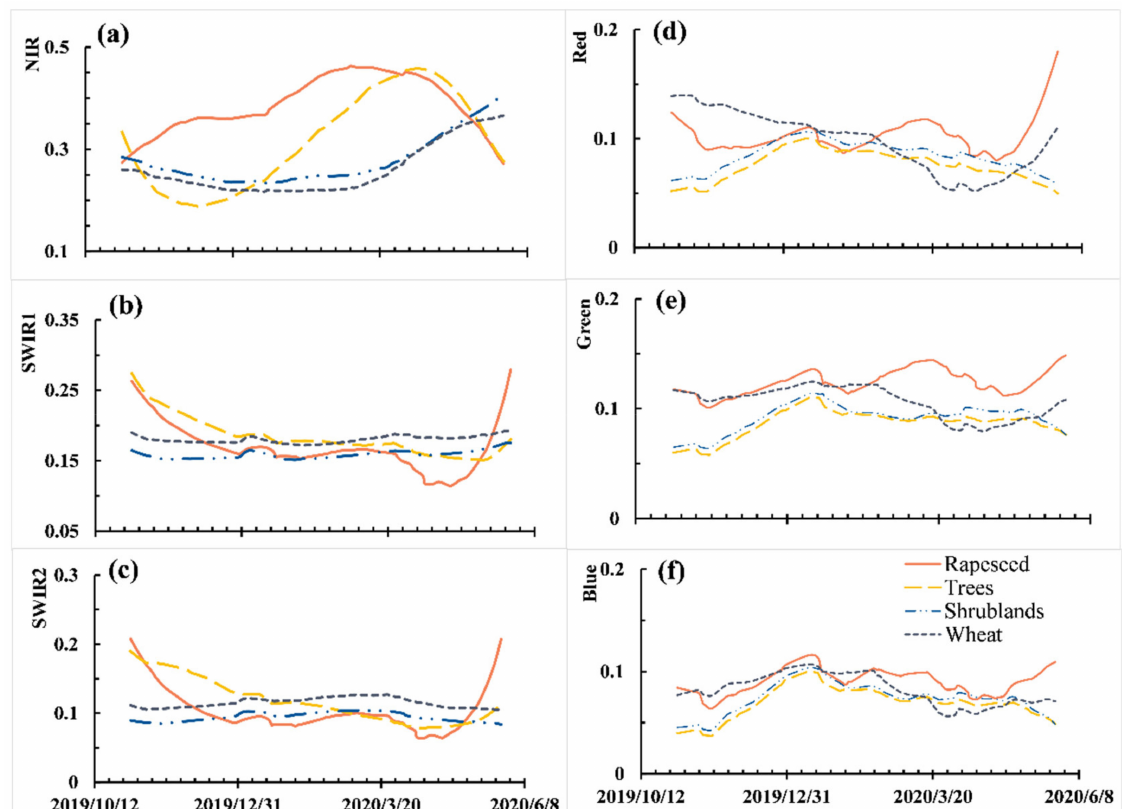
Figure 4. Temporal spectral profile of different landcovers at ( a ) near-infrared, ( b ) short-wave infrared 1, ( c ) short-wave infrared 2, ( d ) red, ( e ) green, and ( f ) blue wavebands.